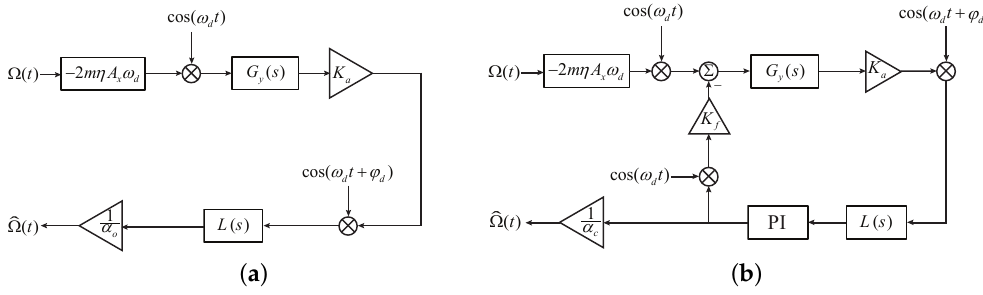
Figure 1. Block diagrams of the sense channel in MEMS vibratory gyroscopes. ( a ) The open-loop operation; ( b ) The force-rebalance